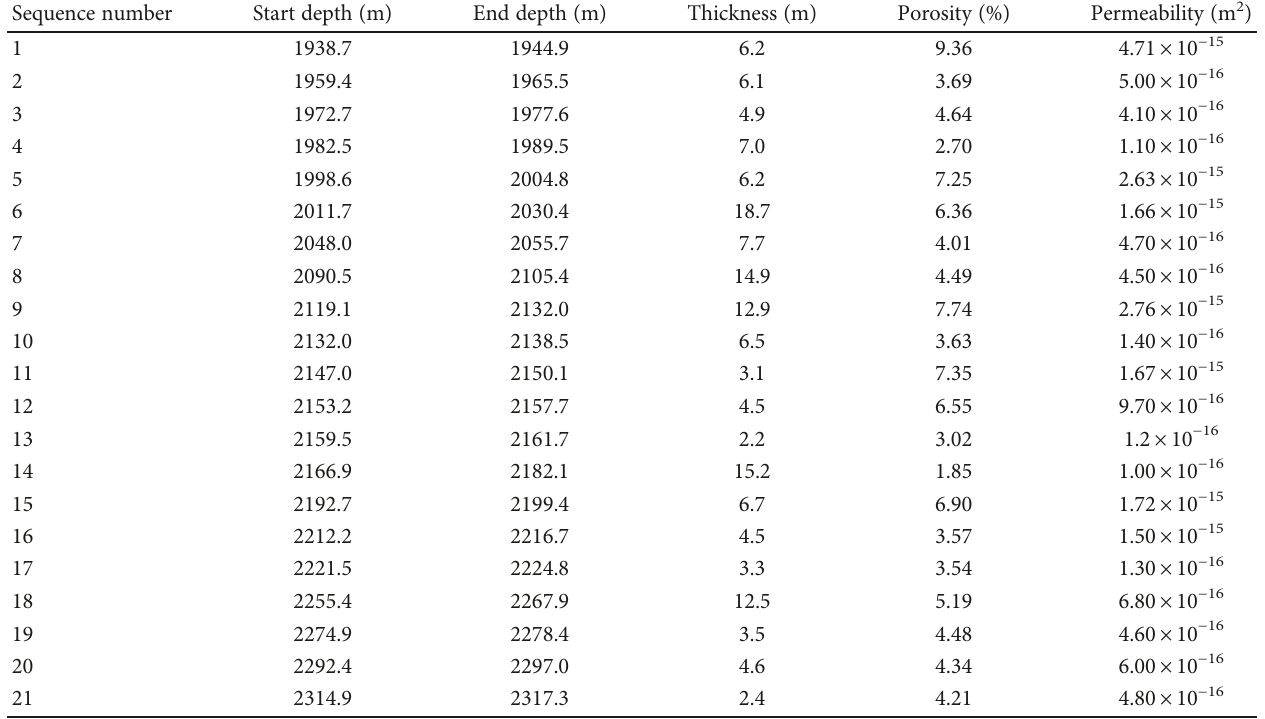
Table 6: The logging interpretation of the geothermal reservoir at DL-6